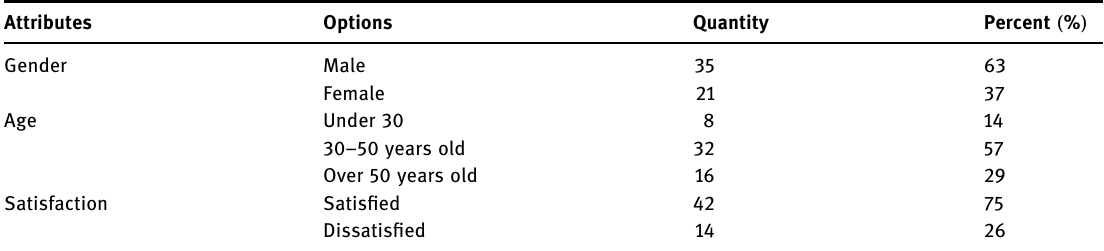
Table 2: Satisfaction survey of construction